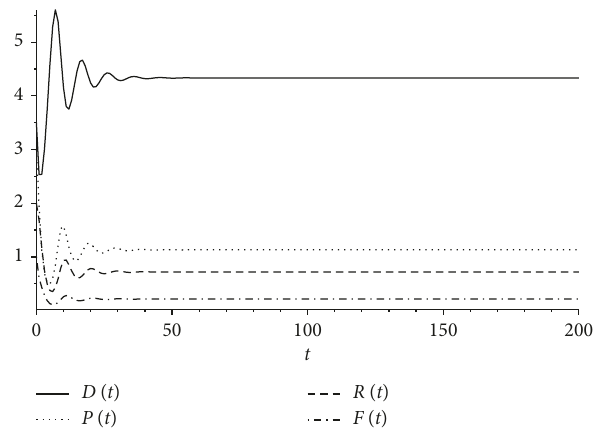
Figure 2: Numerical simulation diagram of system (2) when � 0 , τ � 0. τ 1 2